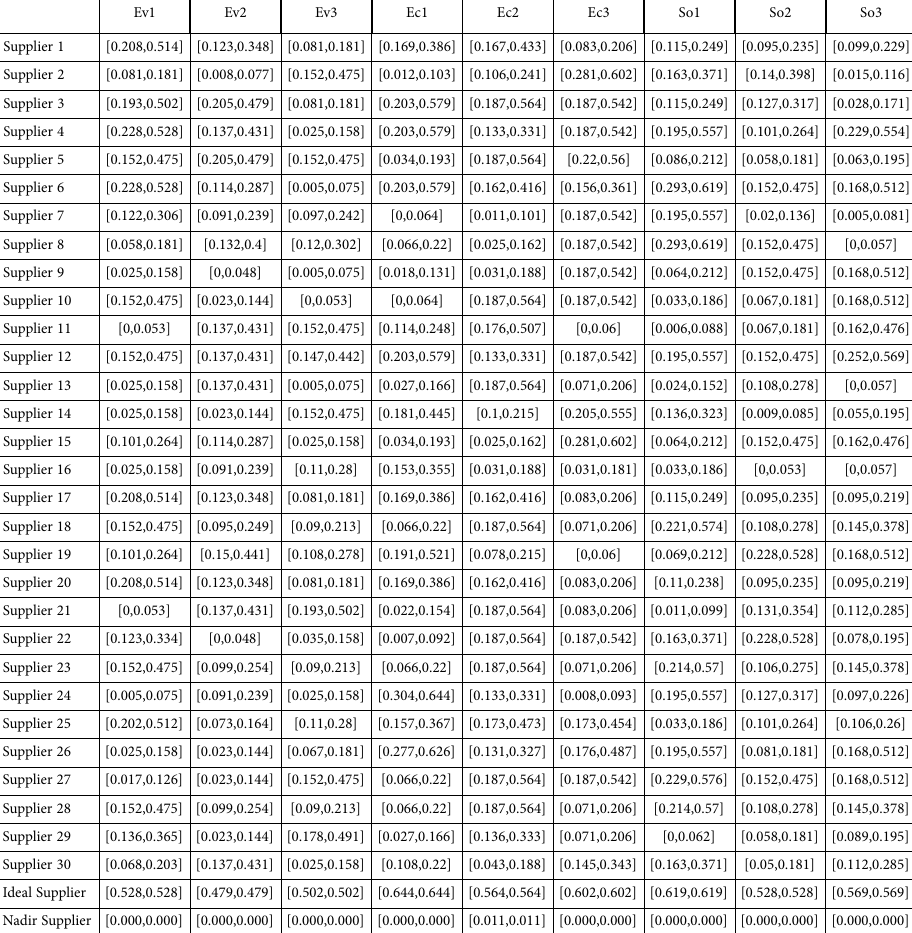
Table 8. Adjusted grey scores of suppliers on sustainability factors